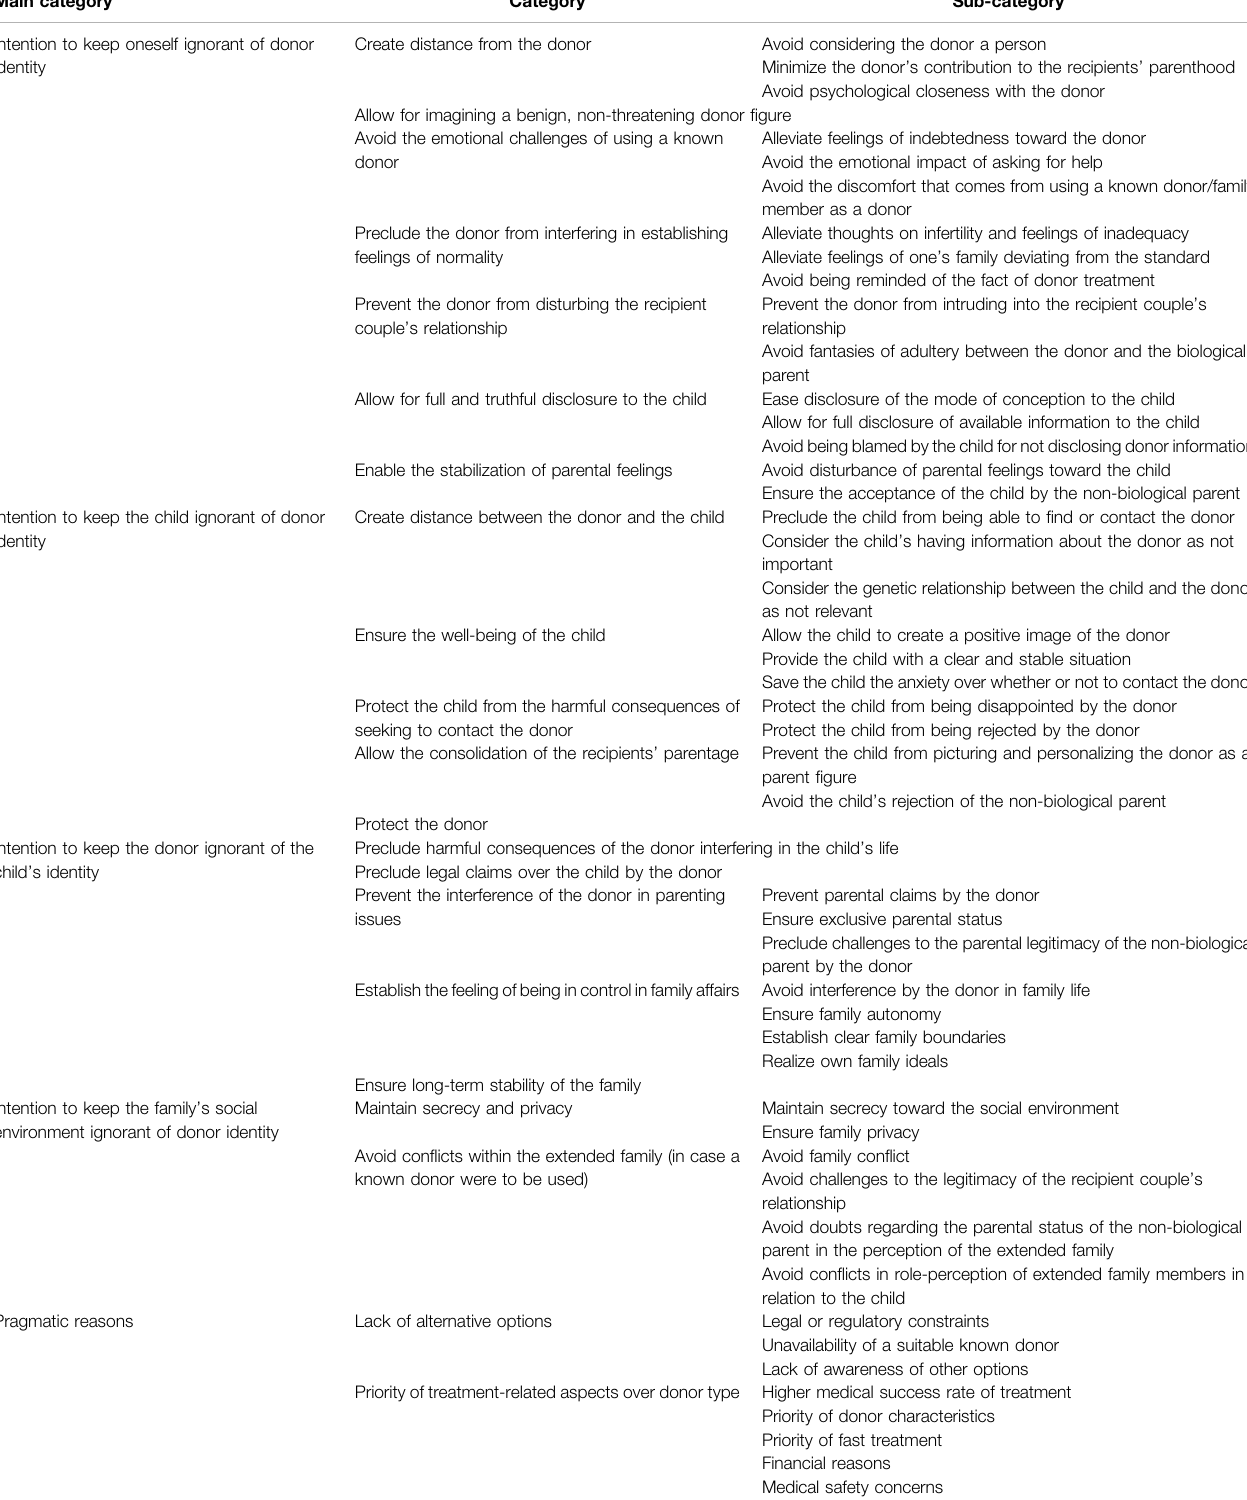
TABLE 2 | Dimensions of recipients ’ motives underlying a preference for donor